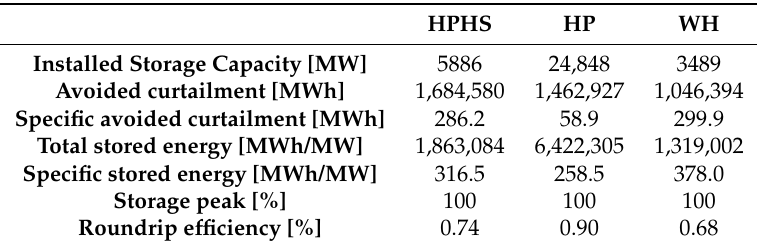
Table 4. Storage technologies